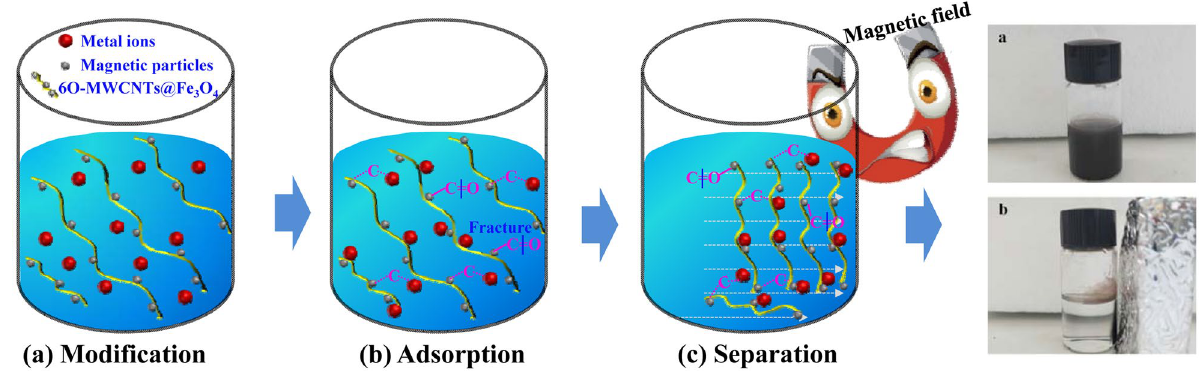
Figure 12. The mechanism of 6O-MWCNTs@Fe 3 O 4 adsorbing heavy metal ions in wastewater.